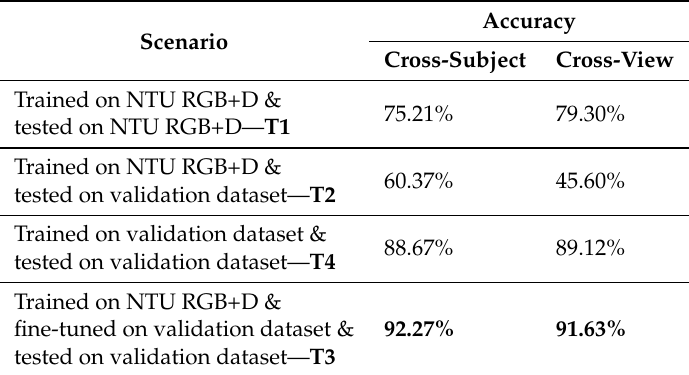
Table 15. The results obtained for the proposed architecture.